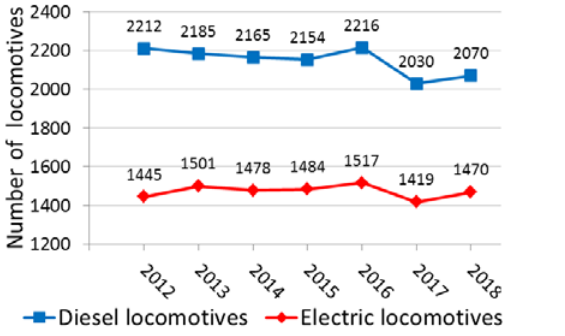
Fig. 5. Freight locomotives in Poland in the years